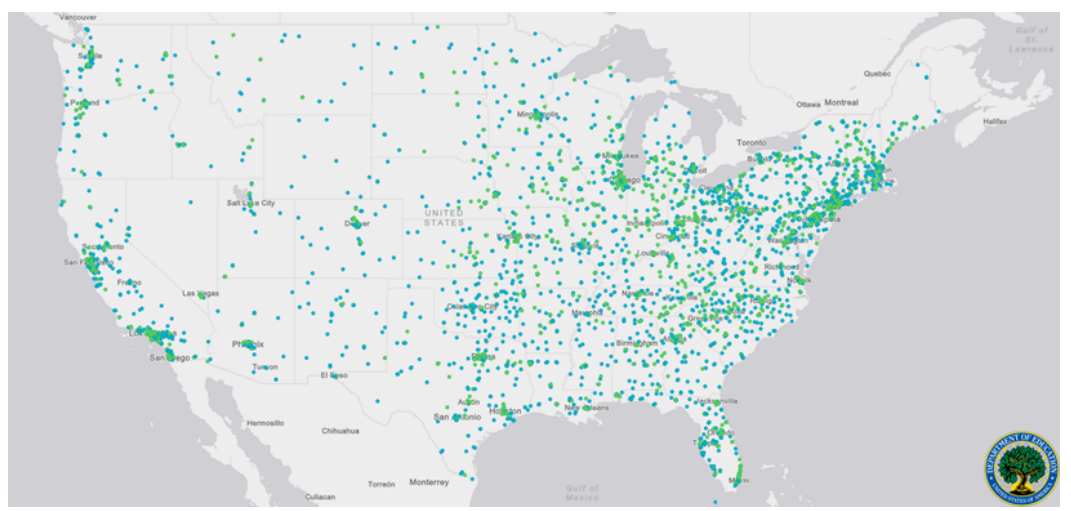
Figure 3. A national map identifying higher education institutions across the United States. Blue dots are used to represent public universities, and green dots represent private not-for-profit